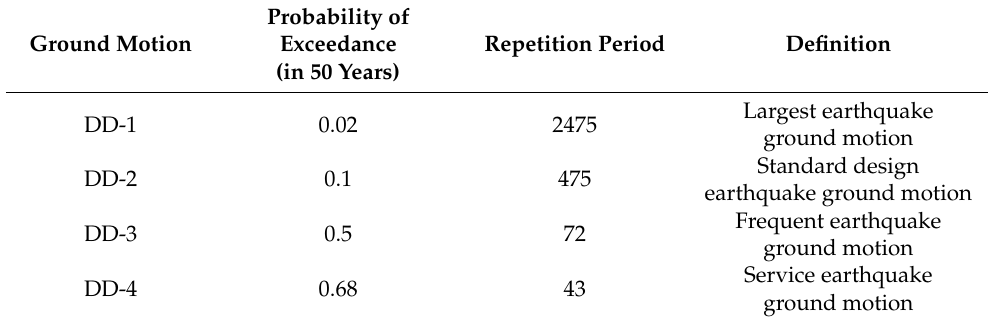
Table 1. Earthquake ground motion levels [17].